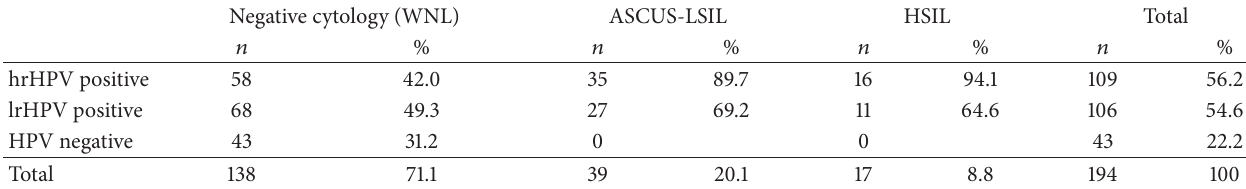
Table 3: Cytology score of the ThinPrep slides versus HPV testing.